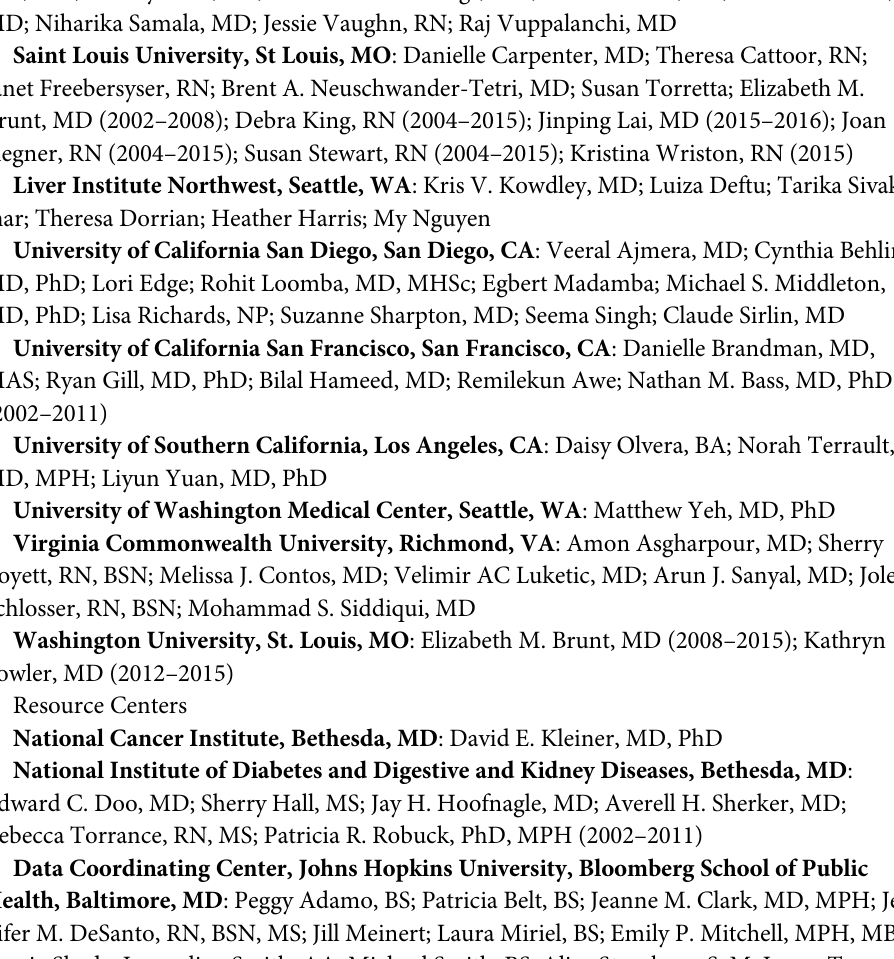
S1 Table. % at-risk NASH and FAST ™ by fibrosis